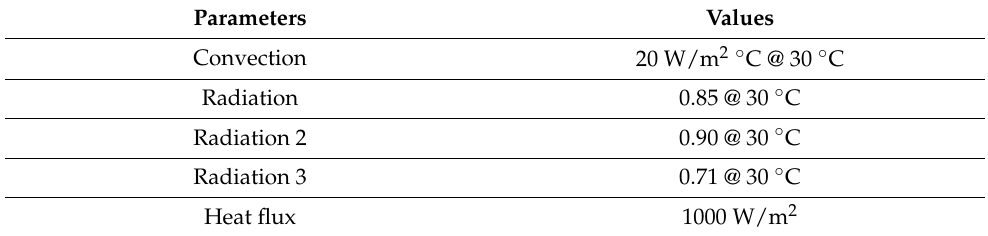
Figure 9. Results of temperature and stresses of the studied cases. ( a ) Field temperature distribution of the geometries studied; ( b ) Field stress distribution of the geometries studied. Table 2. Results of different